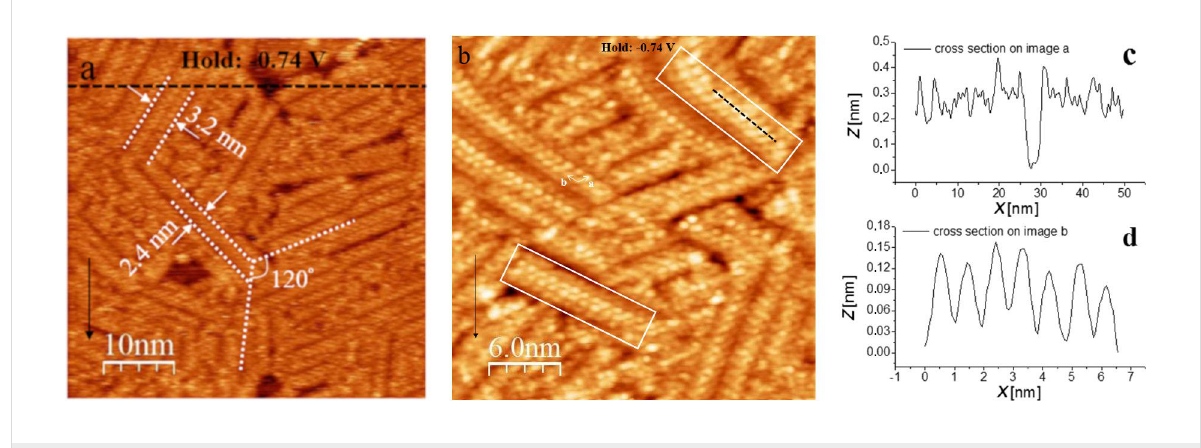
Figure 5: STM images of the Sb adlayer structure on Au(111) in 0.25 mM Sb 2 O 3 /0.5 M H 2 SO 4 electrolyte at − 0.74 V. (a) 50 × 50 nm; (b) 30 × 30 nm; (c) the cross section of image a; (d) the cross section of image b. Sample bias of 50 mV, set point = 0.5 nA and scan rate of 12 ln/s. Integral gain: 2 and proportional gain: 3. Arrows indicate the scan direction. Line-by-line correction is used for images.